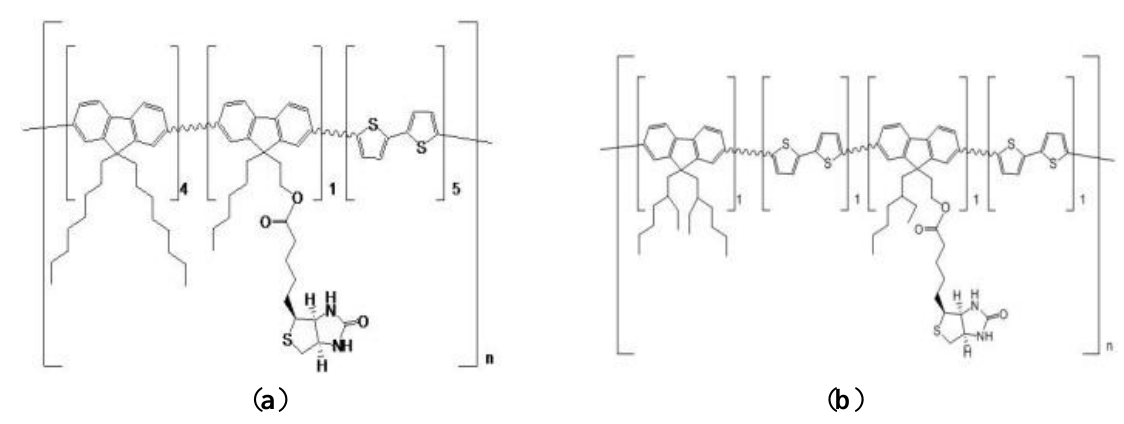
Figure 1. Two types of biotinylated organic semiconductor polymers (F8T2). ( a ) 10% and ( b ) 25% of the total side chains were